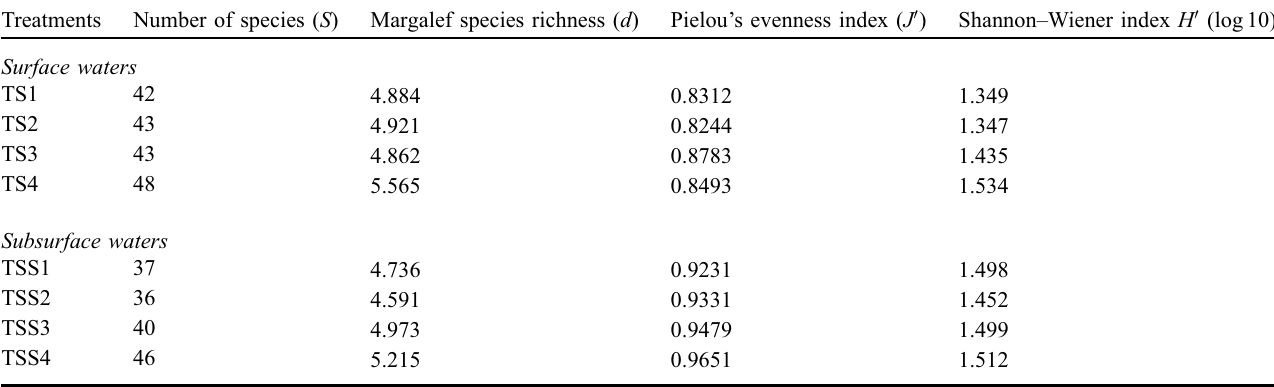
Table 2. Diversity indices of periphyton in surface waters and subsurface waters of pond ecosystems.